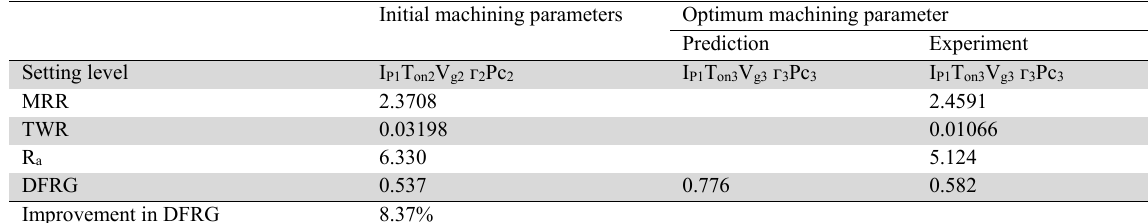
Results of machining performance using initial and optimal machining